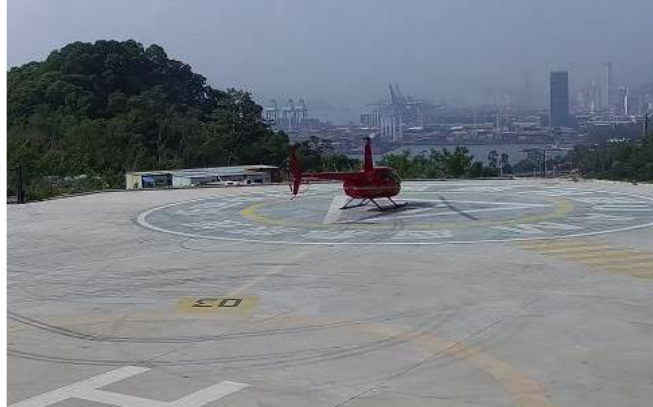
Figure 4. Helicopter to be tested.